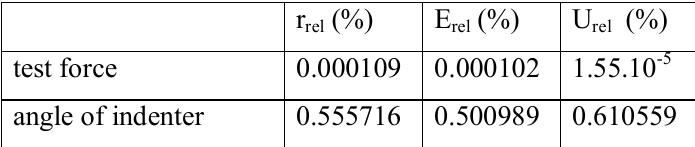
Table 3 - The influence of test force and rotation angle of indenter on r U – p rel